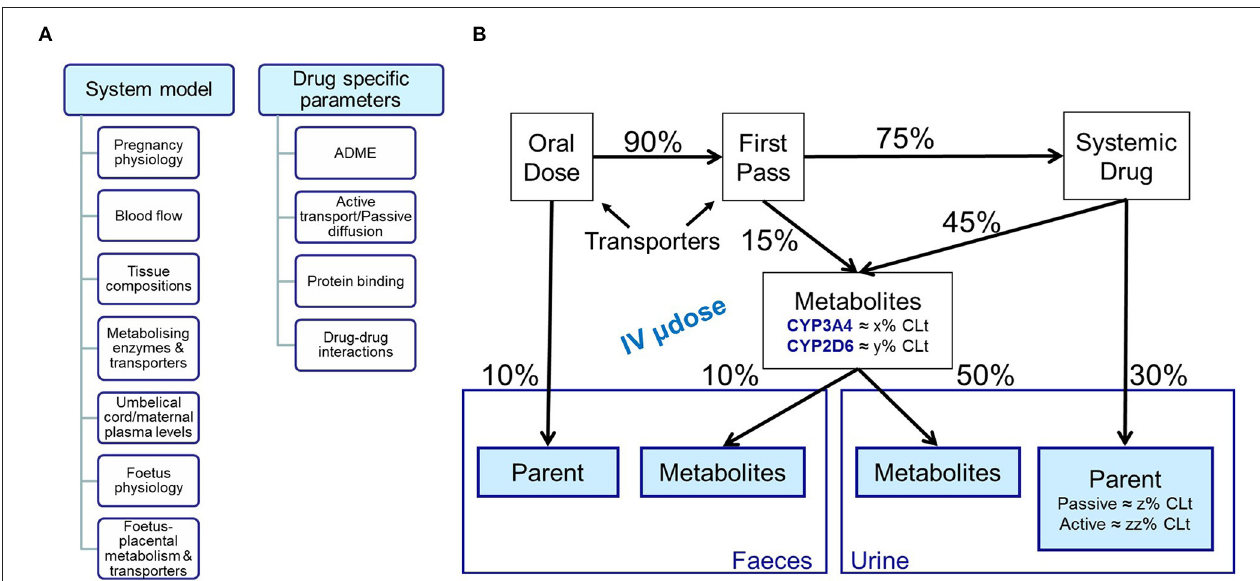
FIGURE 1 | Schematic representation of (A) inputs needed for building both system and drug models; (B) Mass balance diagram following oral and intravenous dosing.